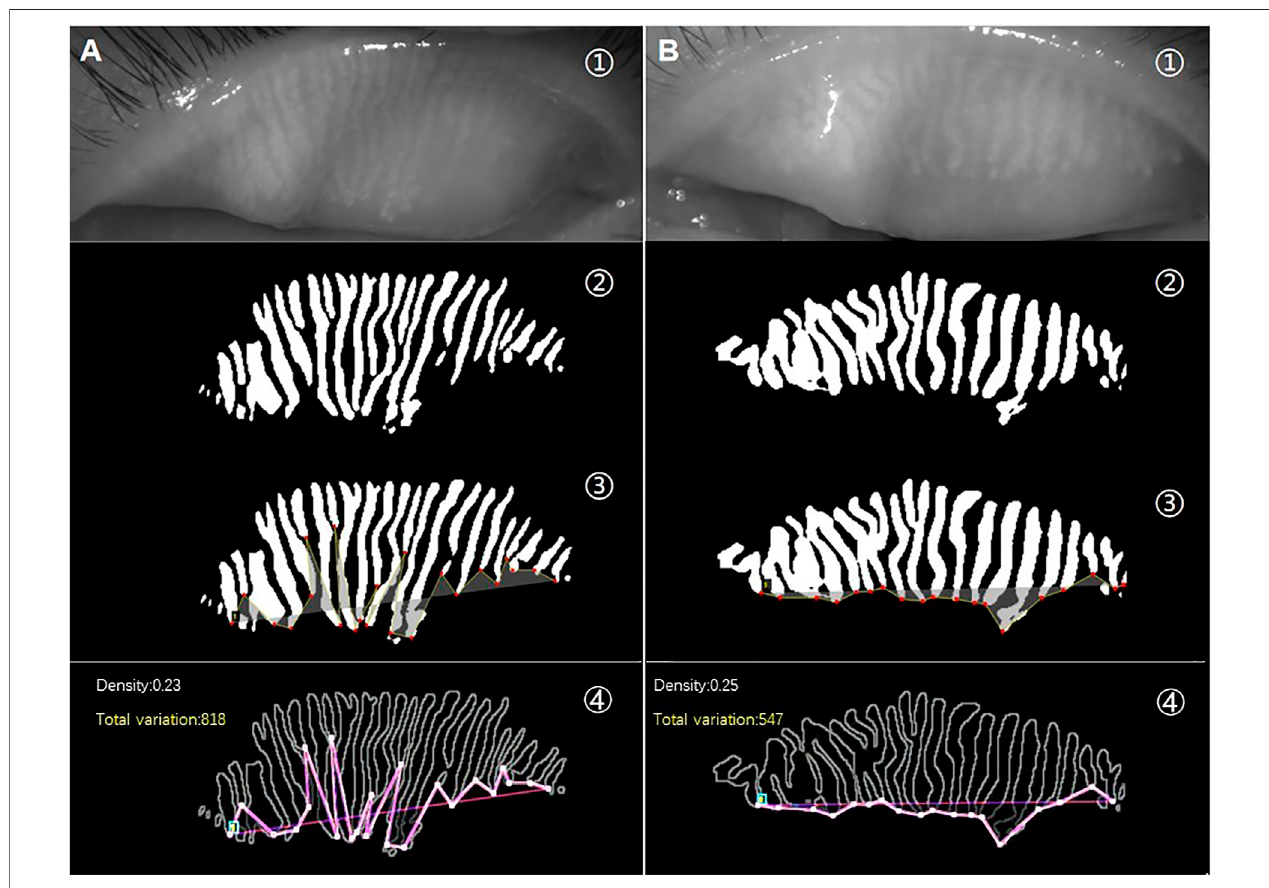
FIGURE 2| (A) isa meibography image from a patient with Demodex blepharitis, and (B) is ameibography image from the control group. The raw images ( ① ) and AIpredictionresultsofthesameimage( ② ).Linesformed byconnectingtheendsofallMGsinthesameimageareshowninyellow( ③ ).Anobviousdifferenceinthepink lines represents total variation between the two meibography images of similar MG density ( ④ ).